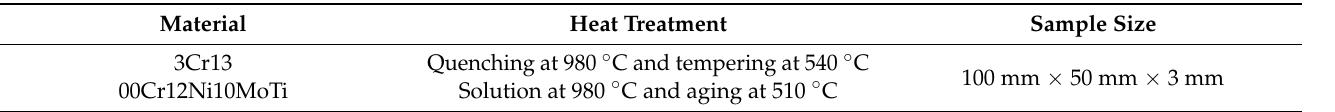
Table 2. Sample state and